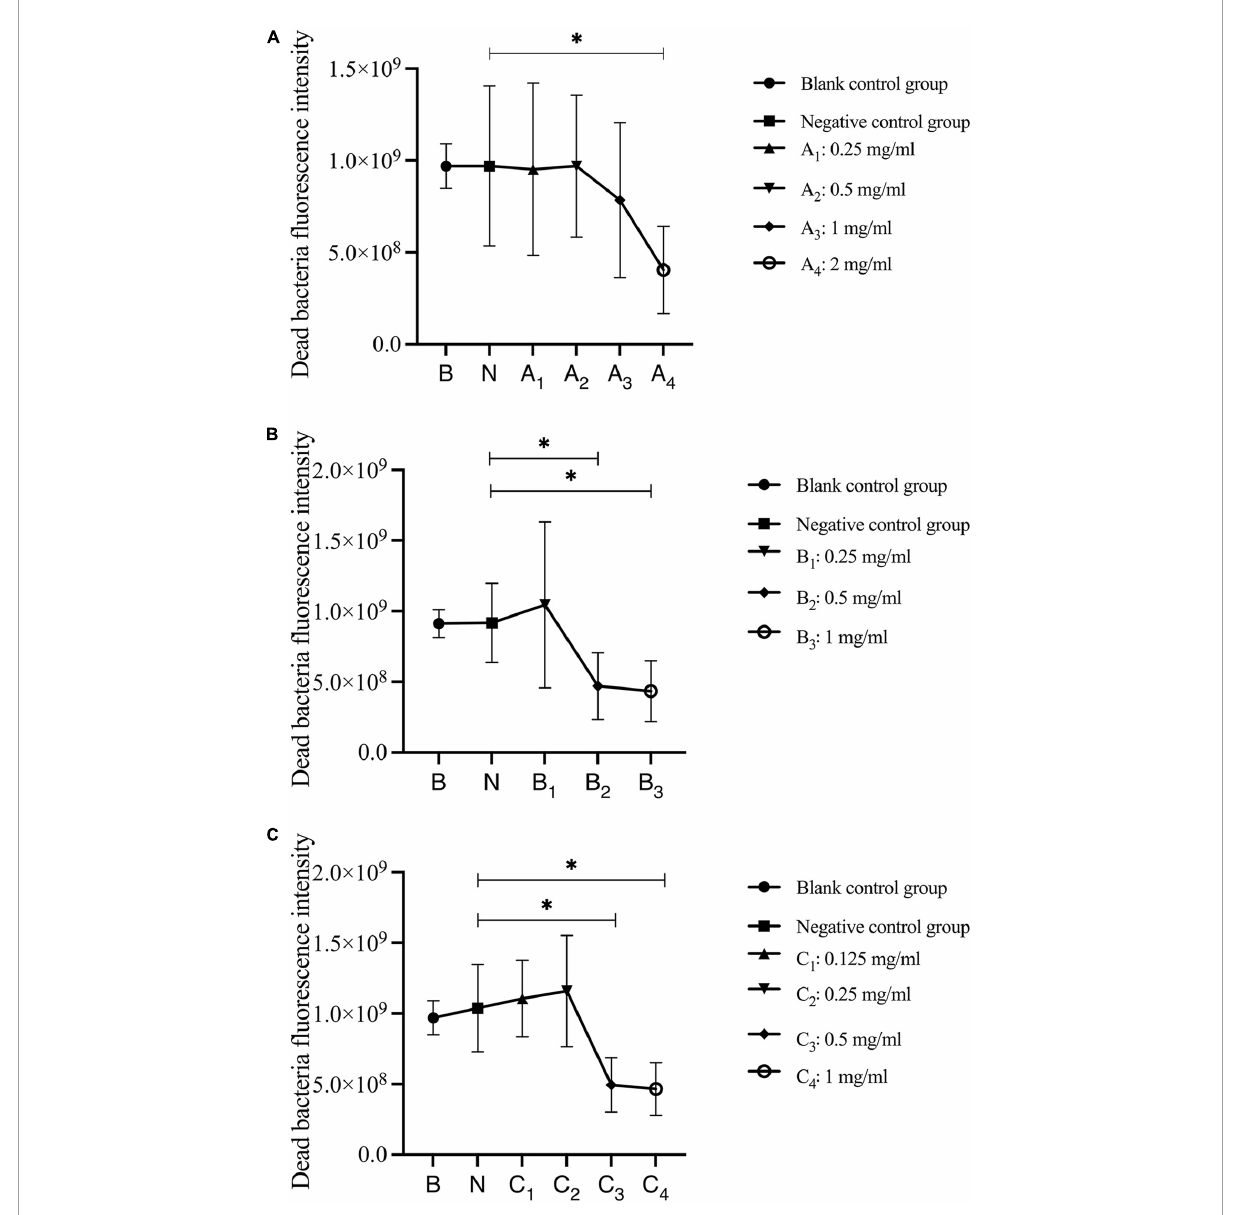
FIGURE7 Quantitative analysis of dead bacteria in biofilm after bovine trypsin treatment for 30 s, 1 min, and 3 min. (A–C) Show the quantitative analysis of biofilm dead bacteria after 30 s, 1 min, and 3 min of bovine trypsin treatment, respectively. ∗ Indicates that there is a statistically significant difference compared with the negative control group ( P <